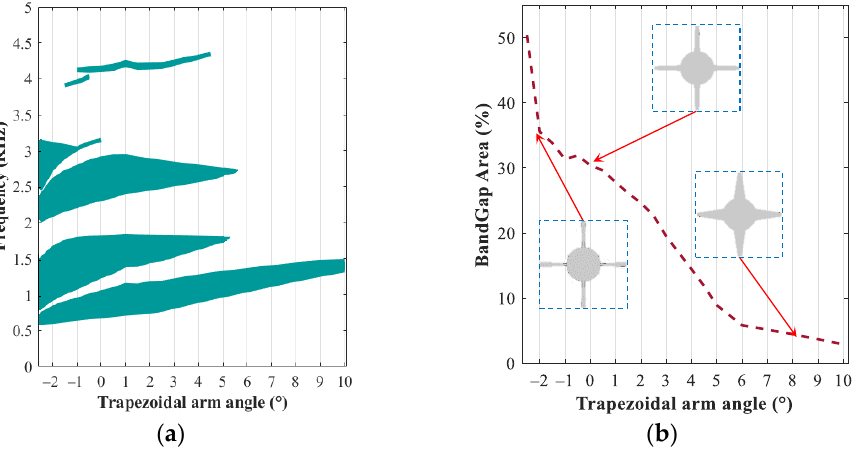
Figure 8. Evolution of bandgap areas in different arm angles ( − 2.5 < θ < 10) in the fixed cylindrical core radius of L / R = 5 and iron volume fraction of 13.94%: ( a ) bandgap area; ( b ) percent of bandgap area in the range of 0 and 5 kHz .